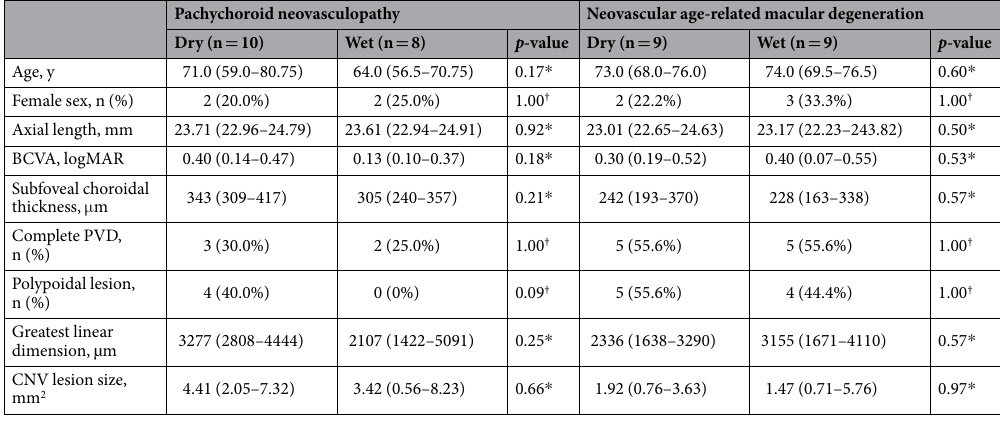
Table 4. Factors Associated with Dry Macula after the First Aflibercept Injection in Patients with Pachychoroid Neovasculopathy and Neovascular Age-related Macular Degeneration. Values are the median (interquartile range). * Wilcoxon signed-rank test. † Fisher’s exact test. BCVA = best-corrected visual acuity; CNV = choroidal neovascularisation; logMAR = logarithm of the minimal angle of resolution; PVD = posterior vitreous